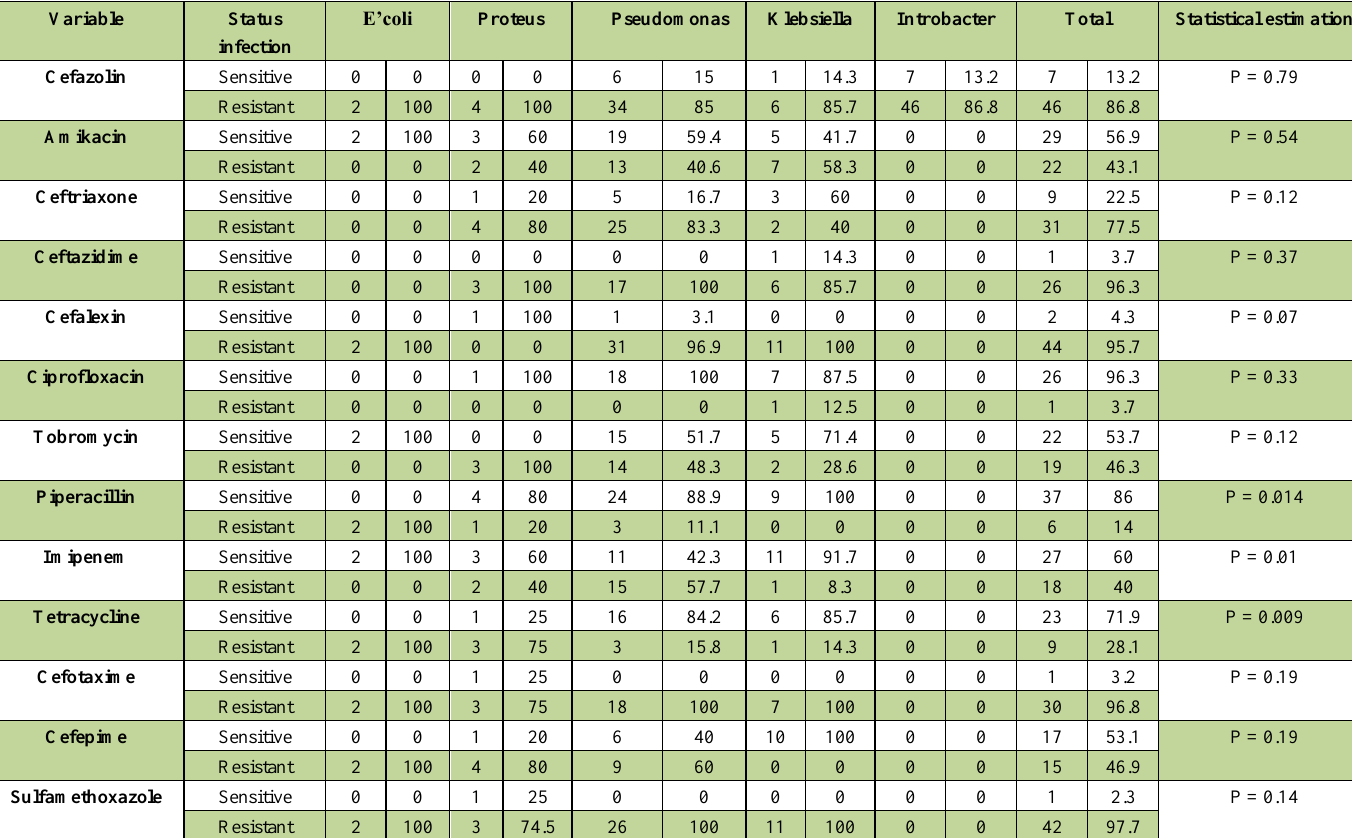
Table10. Antibiogram Response Pattern to Different Types of Bacterial Agents Cultivated in Patients Admitted to ICU at the Time of Admission. Variable